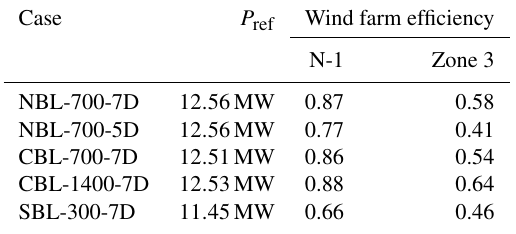
Table 2. Reference power of a single turbine in free-stream condi- tions and wind farm efficiencies for a small wind farm (N-1) and a large wind farm (Zone 3) for all five